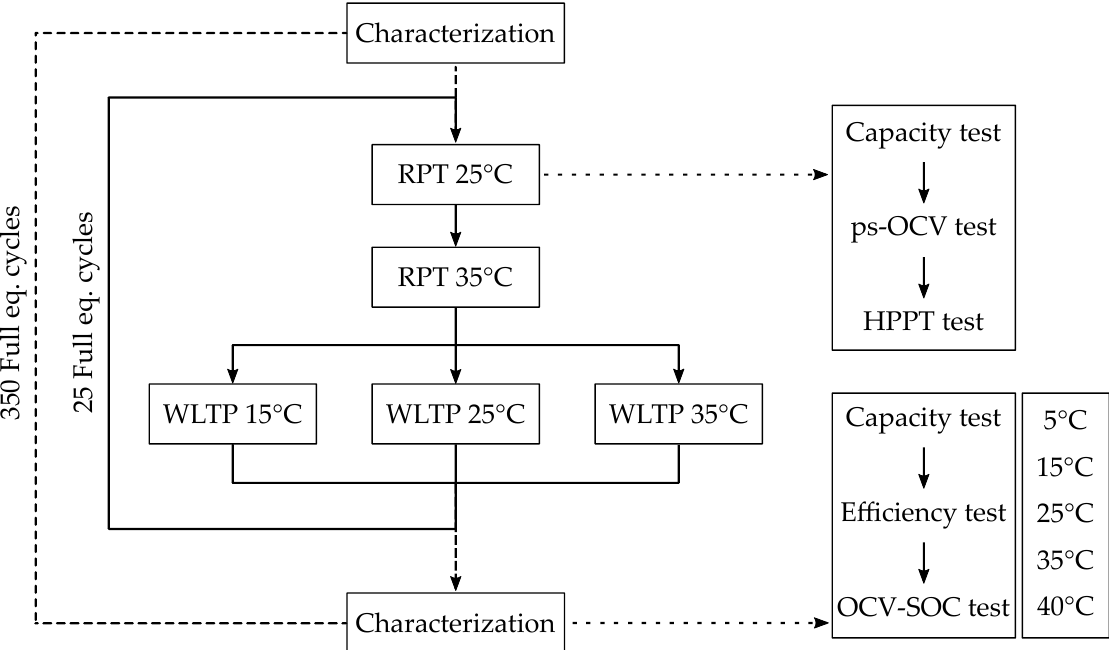
Figure 2. Aging test